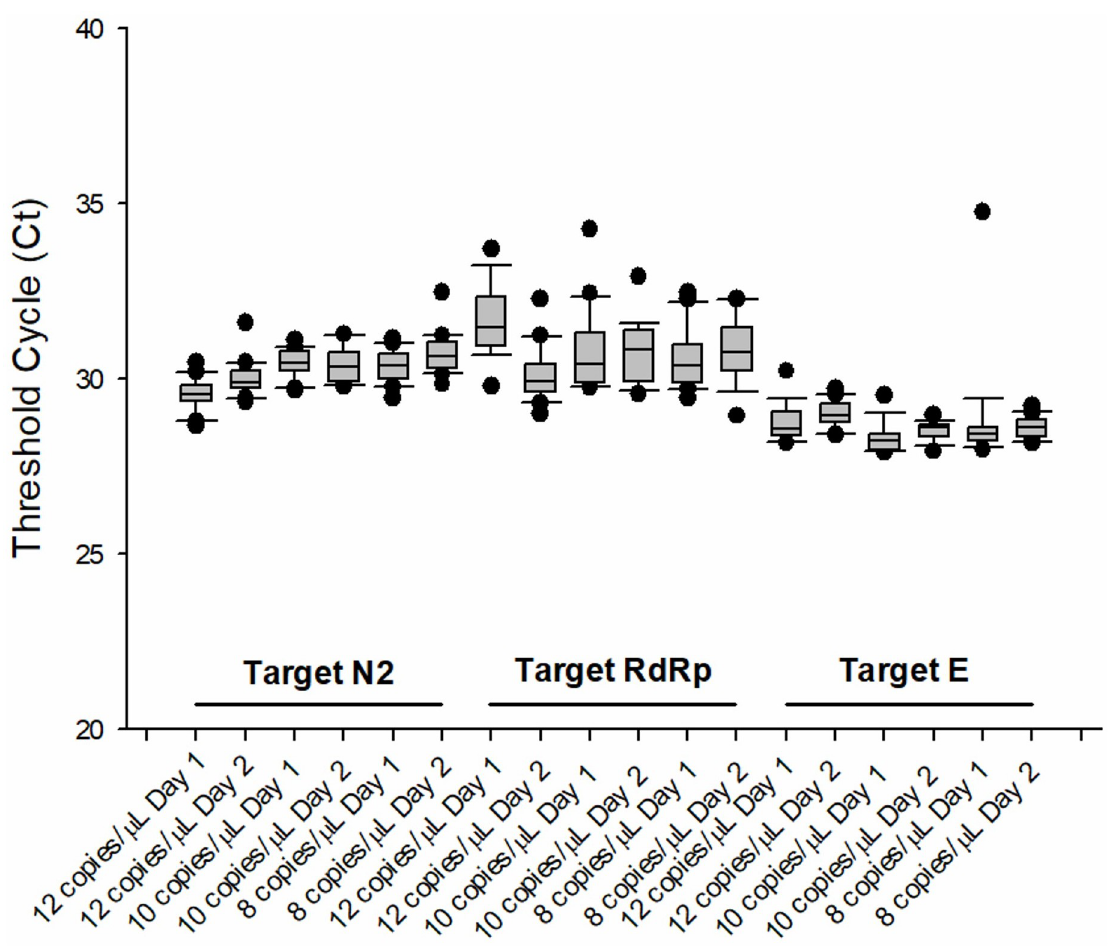
Fig 2. Reproducibility of HRM-RTqPCR assays targeting SARS-CoV-2 E, N and RdRp. SARS-CoV-2 templates were assayed in 40 technical replicates, at 12, 10 and 8 copies/ μ L.